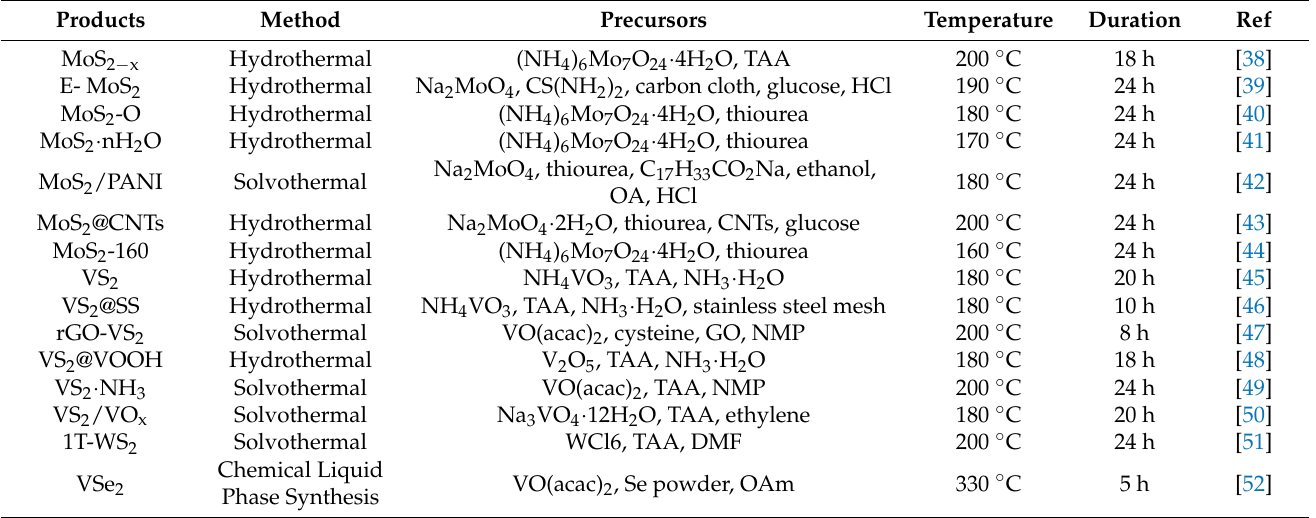
Table 1. Fabrication methods, precursors and synthesis conditions of TMDs as ZIBs cathode.